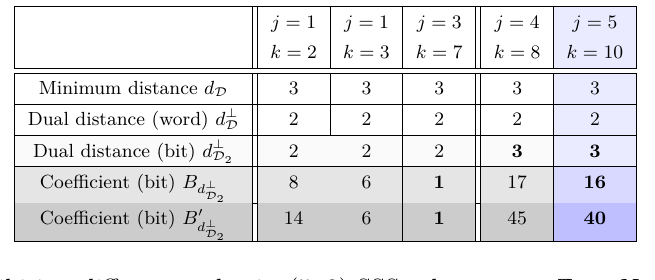
Table 4: Exhibiting different codes in (5 , 2)-SSS scheme over F 2 8 . Note that we fix α 1 = α i = 1, α 2 = α 8 and enumerate all possible α 3 = α k , α 4 = α l and α 5 = α r